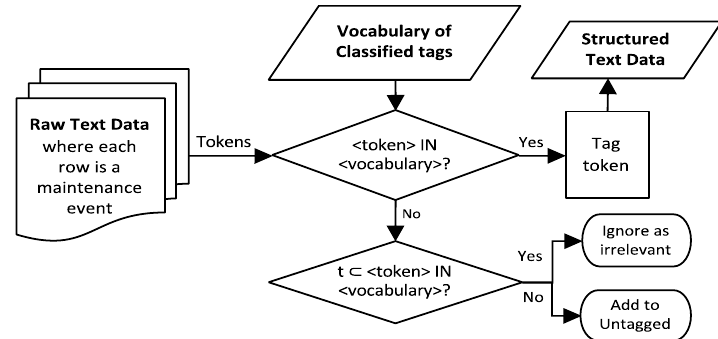
Figure 2. Expert annotation step flowchart.